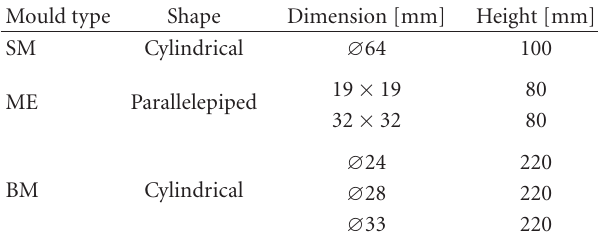
Table 1: Mould geometrical